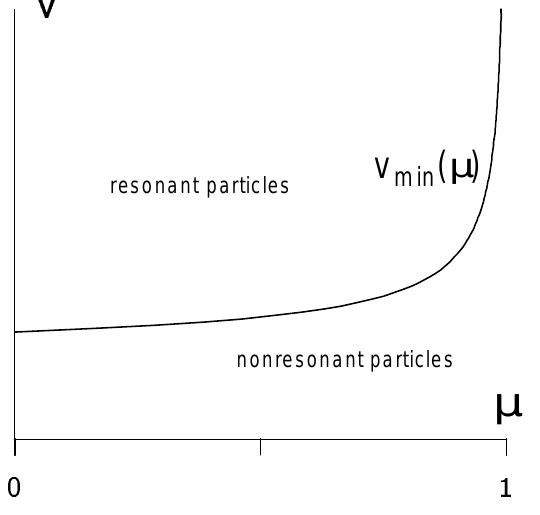
Fig. 9. The boundary between resonant and nonresonant regions for energetic electrons in the phase